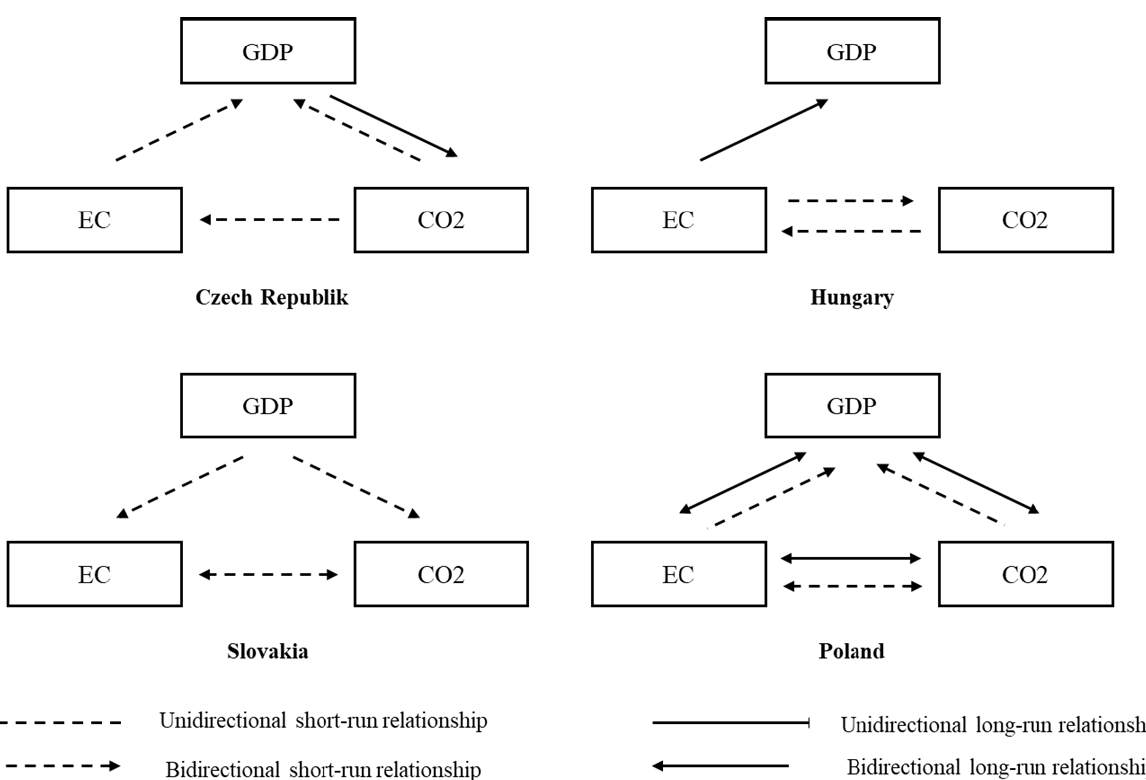
Figure 6. Relationship between variables.